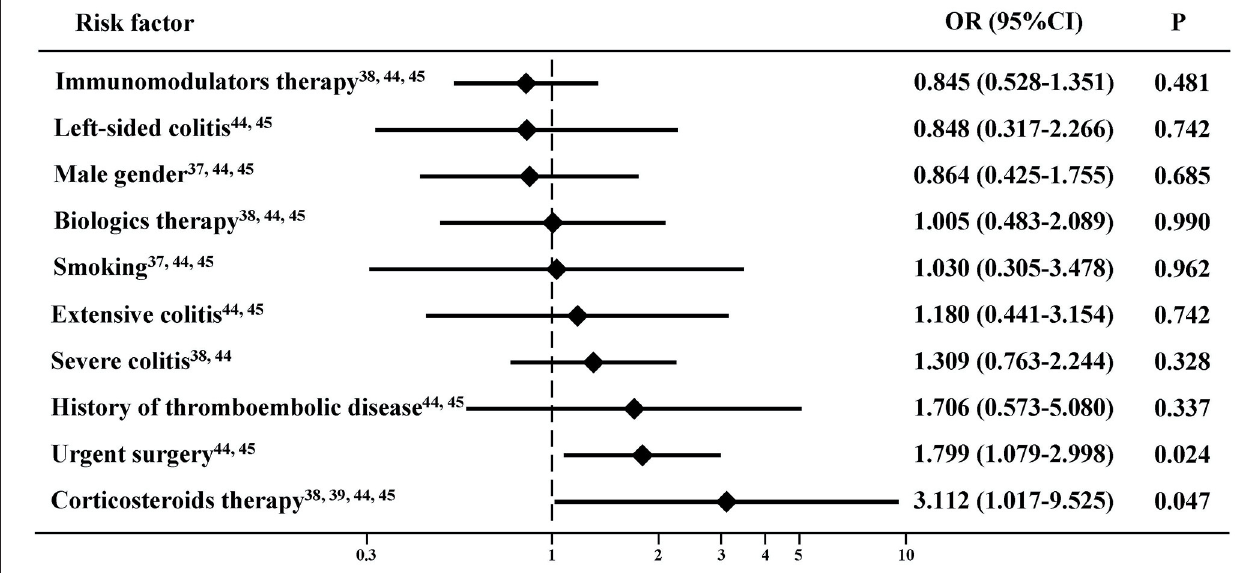
FIGURE 2 | Risk factors of portal venous system thrombosis (PVST) in patients with inflammatory bowel disease (IBD) after colorectal surgery.